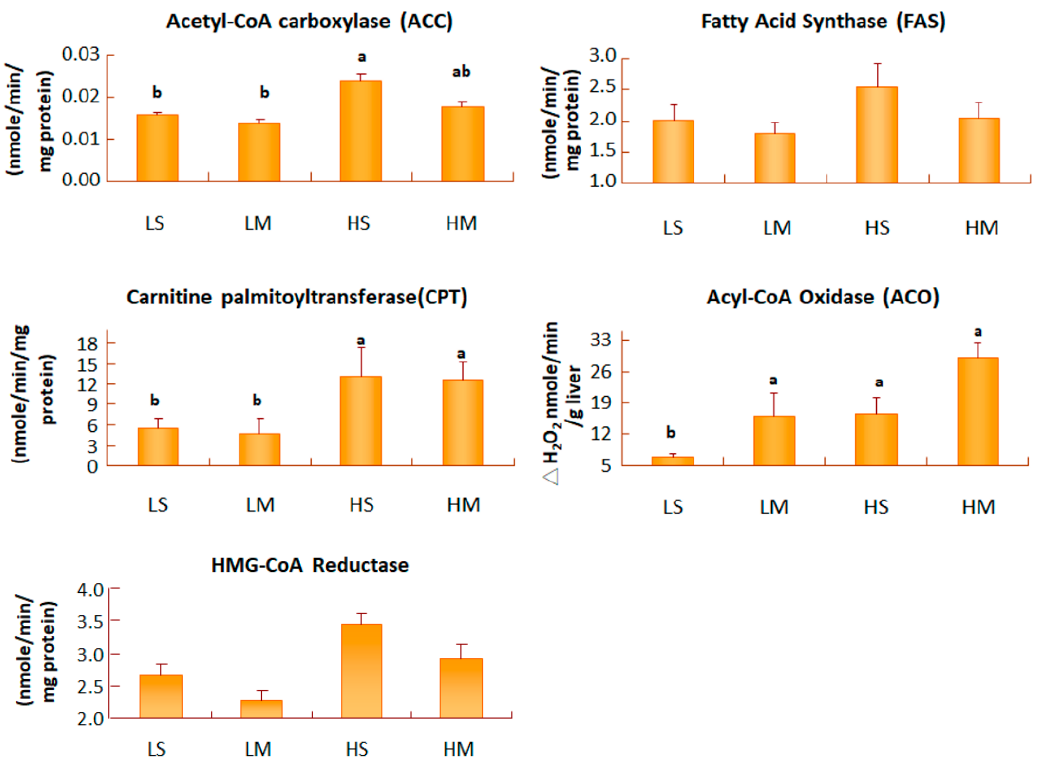
Figure 4. Liver acetyl-CoA carboxylase, fatty acid synthase, acyl-CoA oxidase, carnitine palmityltransferase, and HMG-CoA reductase activities of type 2 diabetes mellitus rats fed the different diets for 8 weeks. Data are expressed as the mean ± SEM ( n = 8 in each group). LS, diet contained 16% soybean oil; LM, diet contained 8% soybean oil and 8% medium-chain triglyceride oil; HS, diet contained 58% soybean oil; HM, diet contained 29% soybean oil and 29% medium-chain triglyceride oil. Values with different superscripts significantly differ at p < 0.05.